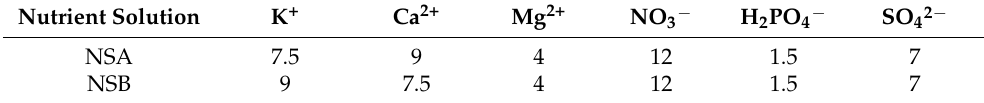
Table 2. Anion–cation proportions (meq L − 1 ) in the NSA and NSB nutrient solutions.